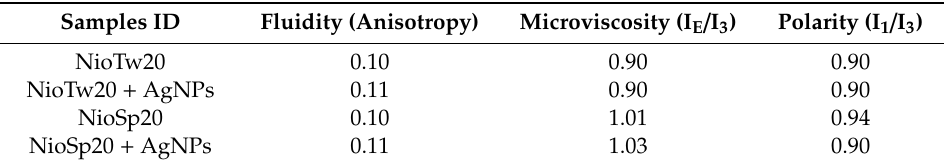
Table 3. Bilayer characterization results of niosomes (Nio) and Nio-AgNPs.